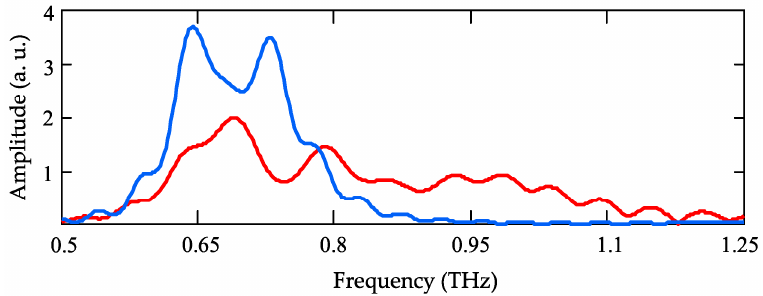
Figure 4. The spectra of THz generation in chirped APPLN crystal for the cases of δ = 1.6 µ m (red curve) and δ = 0.8 µ m (blue